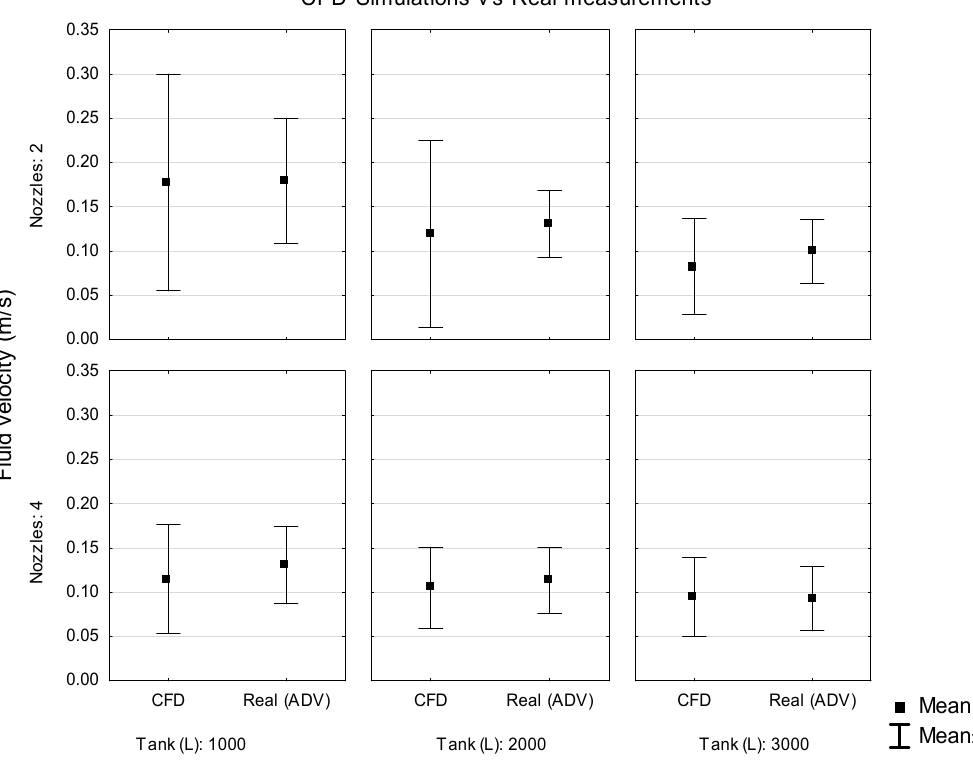
Figure 7. Mean fluid velocities, estimated by CFD and experimentally measured, according to the number of active nozzles.